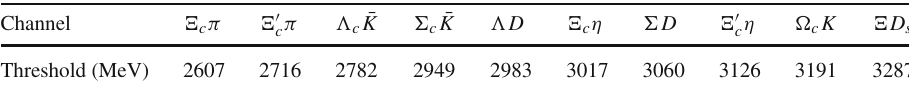
Table 1 Charm sector channels with J P = 1 / 2 − and respective thresholds